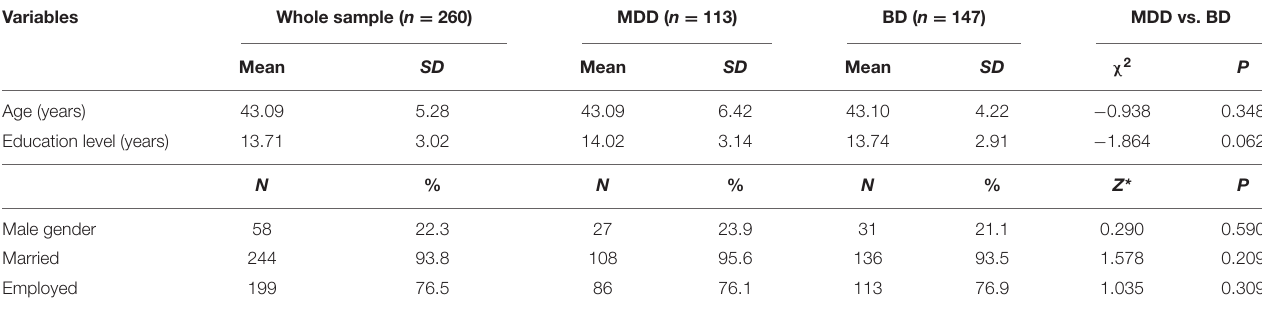
TABLE 2 | Demographic information of participants’ carers.